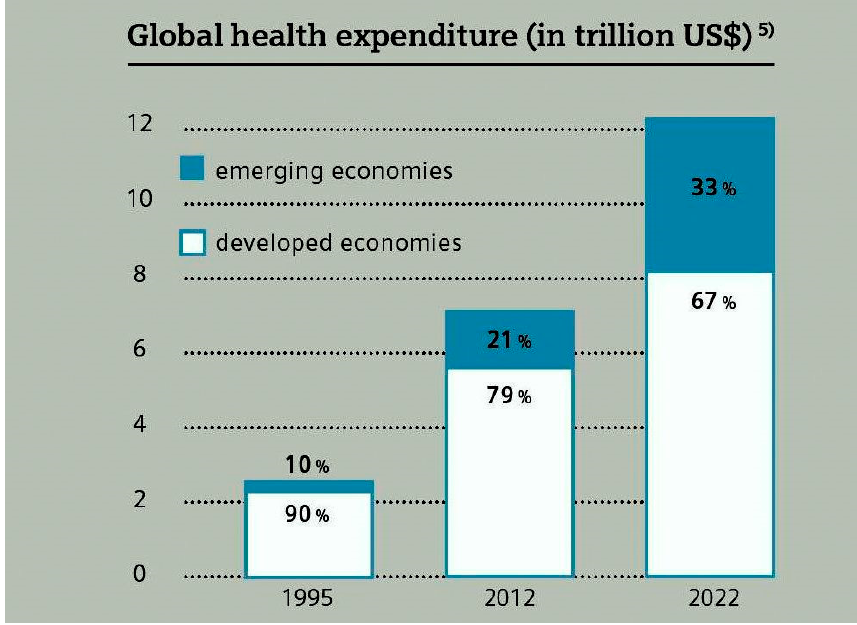
Figure 1. Change in Health Expenditures Globally (in Trillion US$). Source: World Economic Forum.